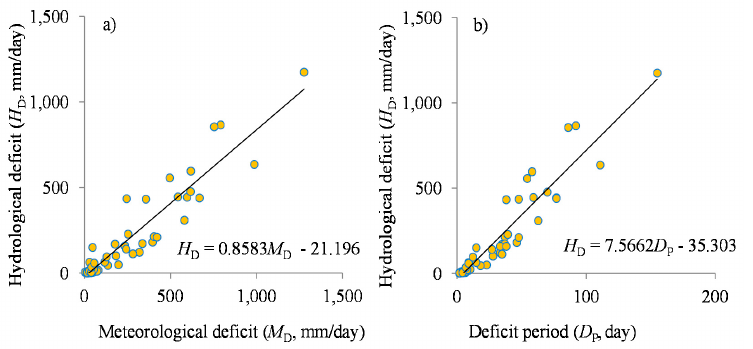
Figure A11. Hydrological deficit versus: ( a ) sum of precipitation insufficiency; and ( b ) deficit period.